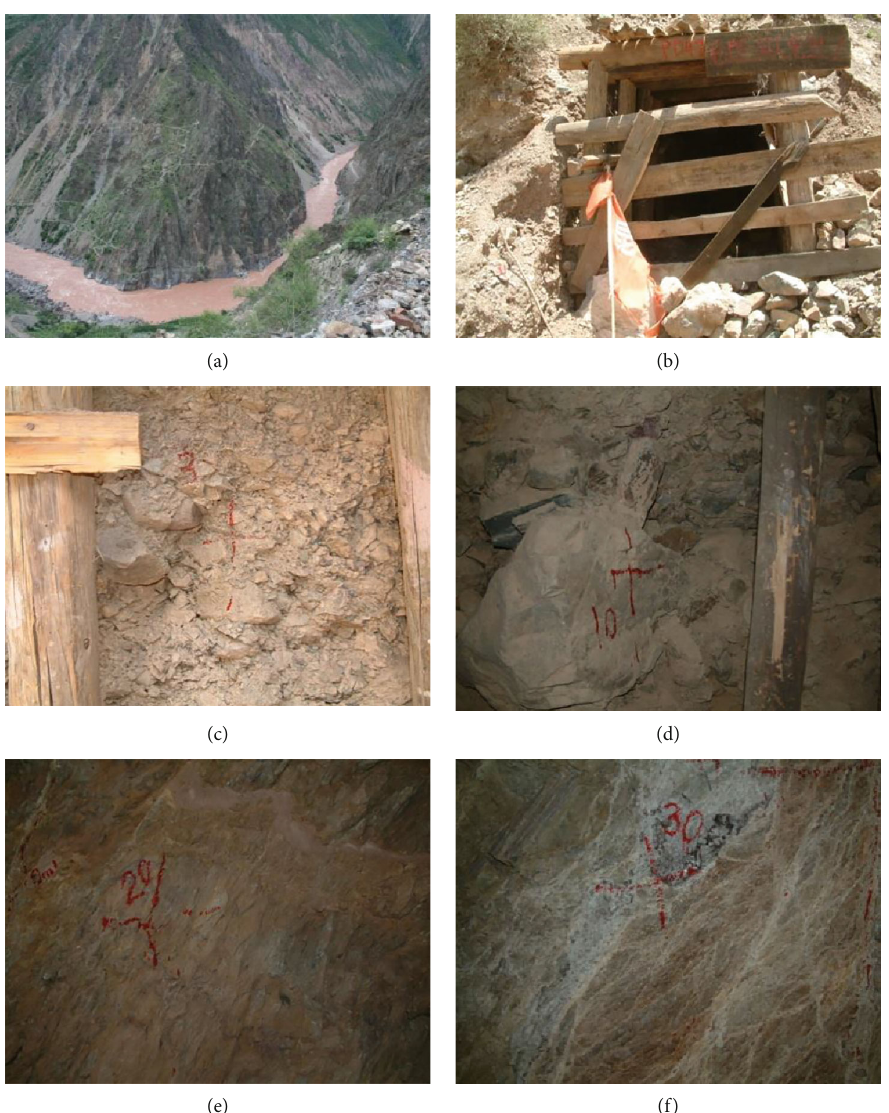
Figure 6: Photos showing the glacio fl uvial deposit slope and strata observed in audit PD17 provided by HydroChina Kunming Engineering Corporation (HCKEC, 2011): (a) a glimpse of the landforms of the deep-cutting river valley and the studied slope; (b) the entrance of exploration audit PD17; (c) soil-stone-blended structure of the glacio fl uvial deposit, observed at 3m horizontal distance from the entrance; (d) geological materials at a contact zone at 10m horizontal distance from the entrance; (e) structures of rock mass at 20 m horizontal distance from the entrance; (f) structures of rock mass at 30m horizontal distance from the